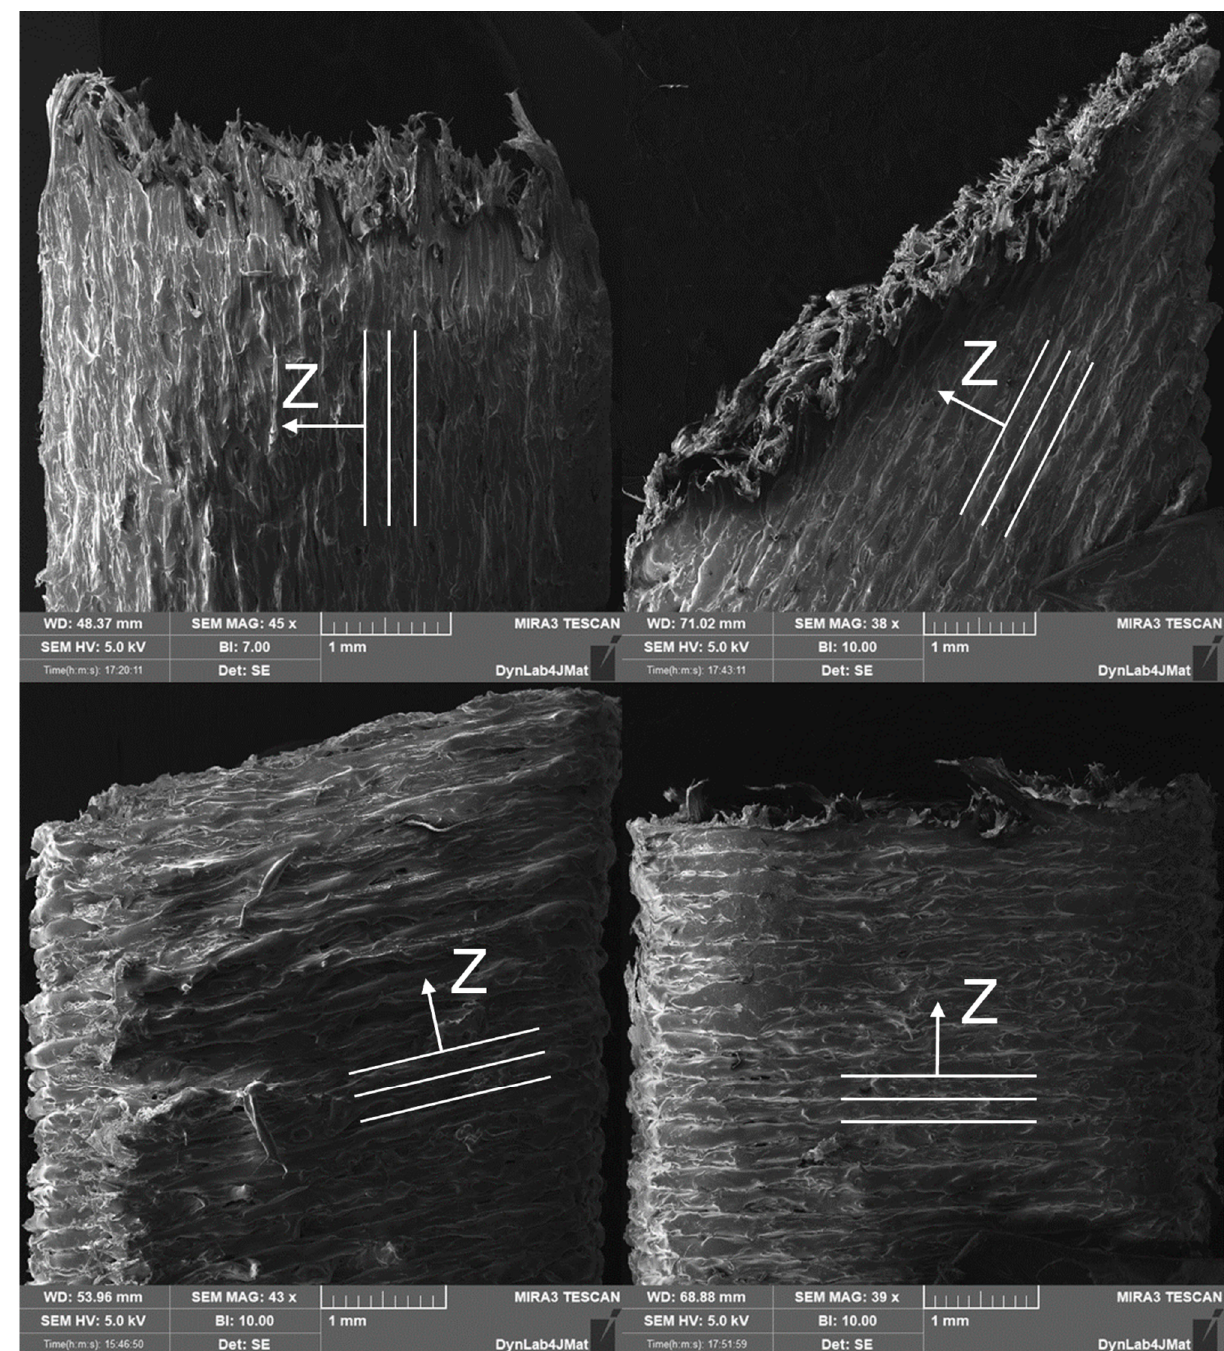
Figure 9. Electron microscope scans of fractured specimens. Broken surfaces of PL specimens (top left), the 30° specimen (top right), the 60° specimen (bottom left), and the 90° specimen (bottom right).